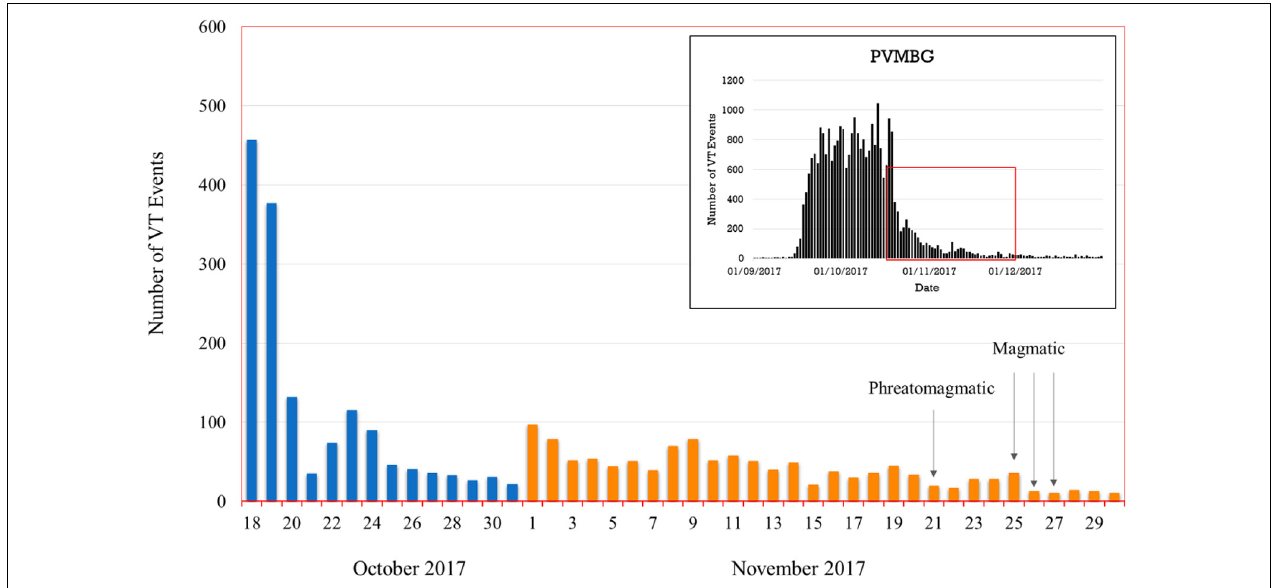
FIGURE 4 | Histogram of the number of detected and located VT events per day from October 18 to November 30, 2017. Colors indicate the date (blue and orange bars are October and November, respectively). Black arrows indicate eruption dates and eruption types. A phreatomagmatic eruption occurred on November 21, 2017; and a magmatic eruption occurred on November 25–27, 2017 (Syahbana et al.,